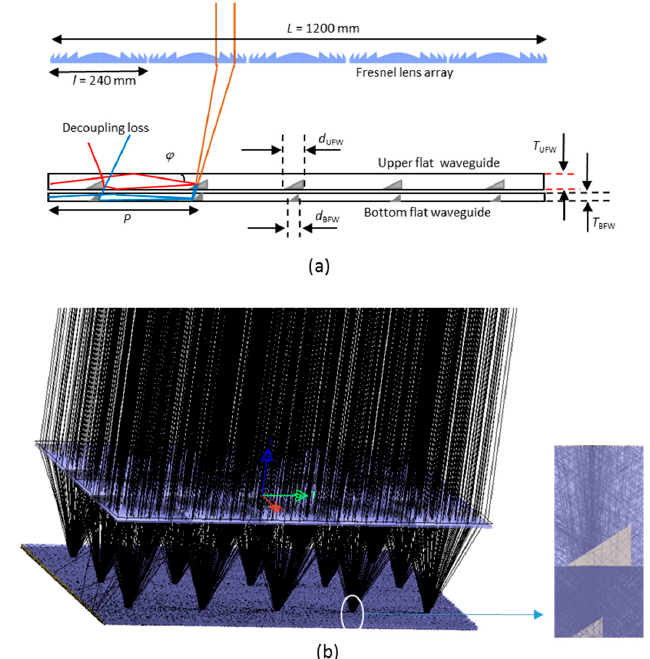
Figure 7. ( a ) Solar spectrum is divided into four bands corresponding to suitable solar cells. ( b ) Illustration of the solar cells at waveguide exit ports in association with other optical elements.